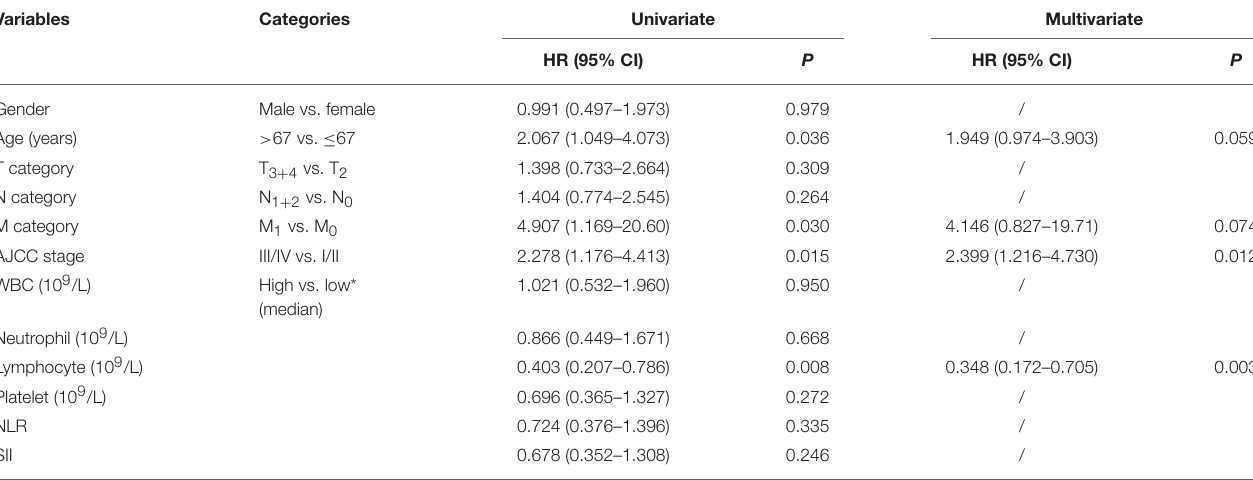
TABLE 2 | Cox proportional hazards model for variables affecting overall survival in rectal cancer